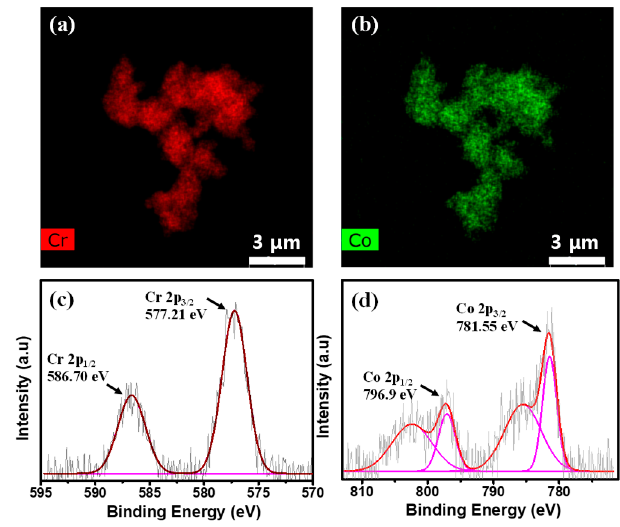
Figure 2. STEM-EDS mapping image of ( a ) Cr atoms and ( b ) Co atoms and X-ray photoelectron profiles of 4 for deconvoluted ( c ) Cr 2p and ( d ) Cobalt 2p core